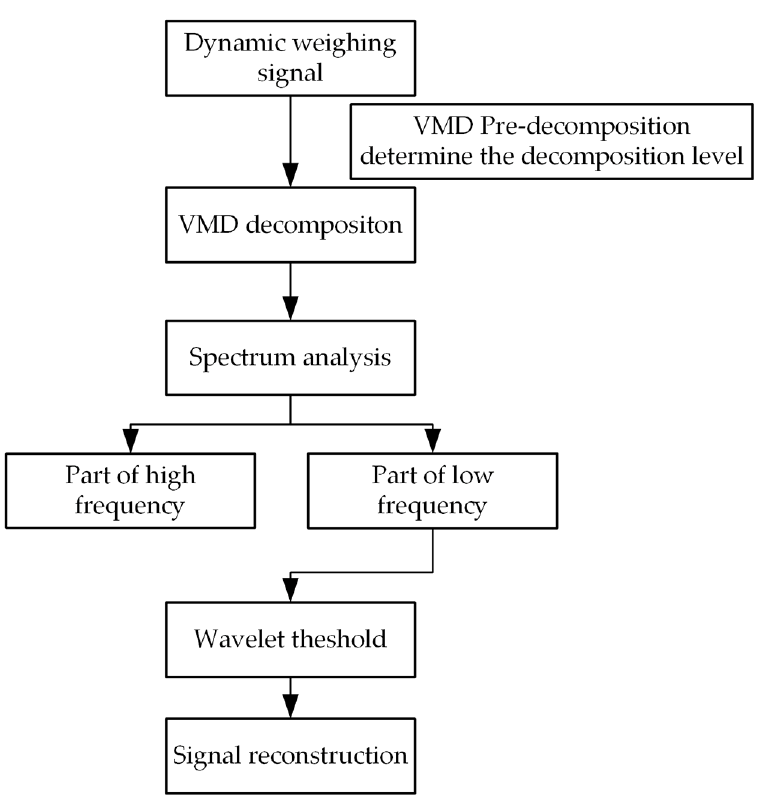
Figure 2. Flow chart of denoising of tea dynamic weighing signal based on VMD − WT.